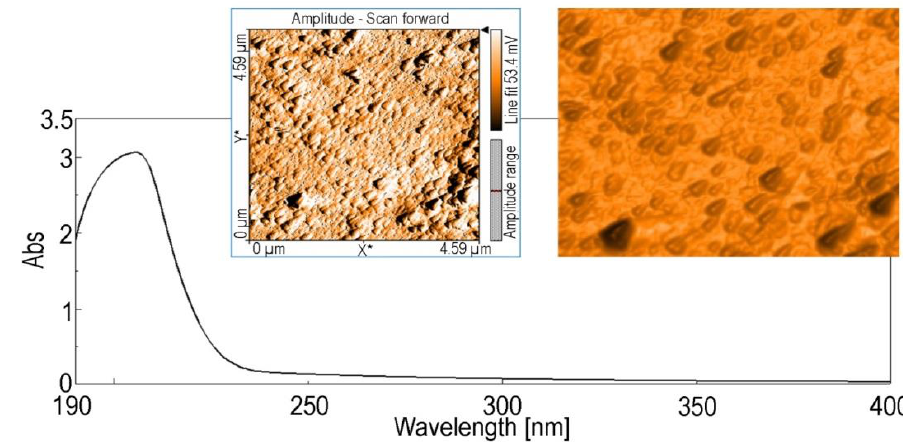
Figure 5. The UV-Vis spectrum of Pt@CuNPs in water, together with 2D and 3D-AFM images. The AFM characteristics are completely different than the shape and size of CuNPs.